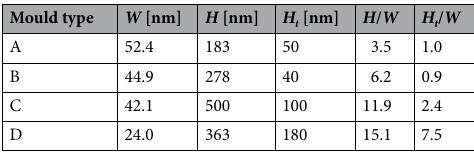
Table 1. Geometrical parameters of the moulds.